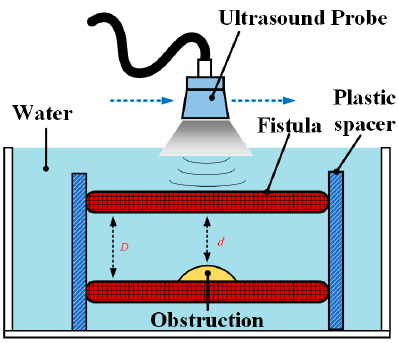
Figure 9. The experimental design of the phantom test by the RUS.